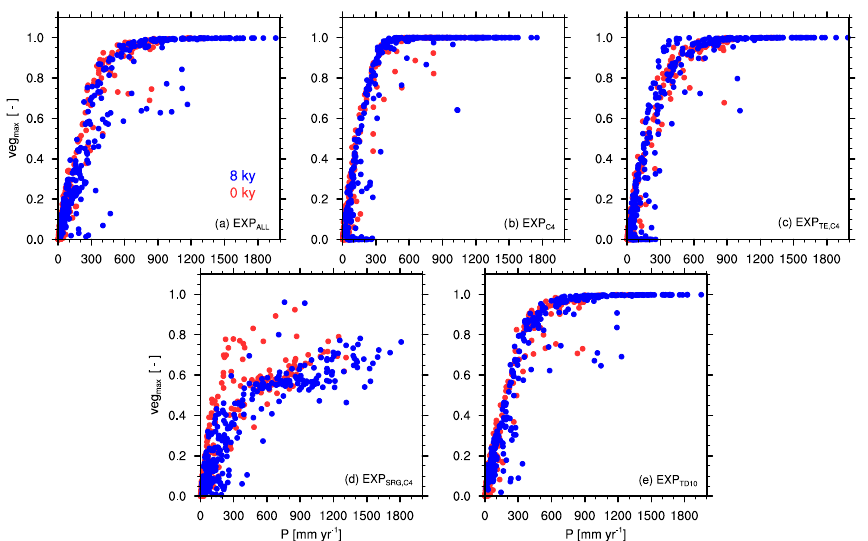
Figure 4. Vegetation–precipitation diagrams (veg max , P ) for simulations with different PFT combinations including all grid cells in the study domain (11.19 to 33.57 ◦ N, 15.94 ◦ W to 40.31 ◦ E). Values are derived from 100-year averages under 8kyr (blue) and 0kyr (red) boundary conditions for EXP ALL (a) , EXP C